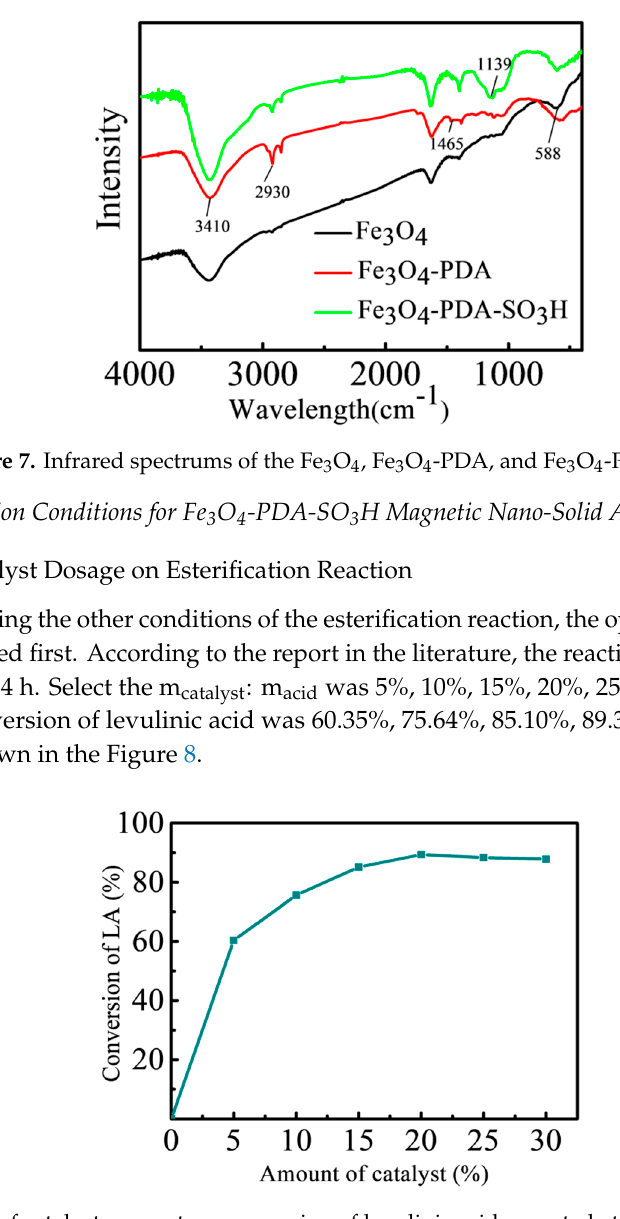
Figure 7. Infrared spectrums of the Fe 3 O 4 , Fe 3 O 4 -PDA, and Fe 3 O 4 -PDA-SO 3 H .